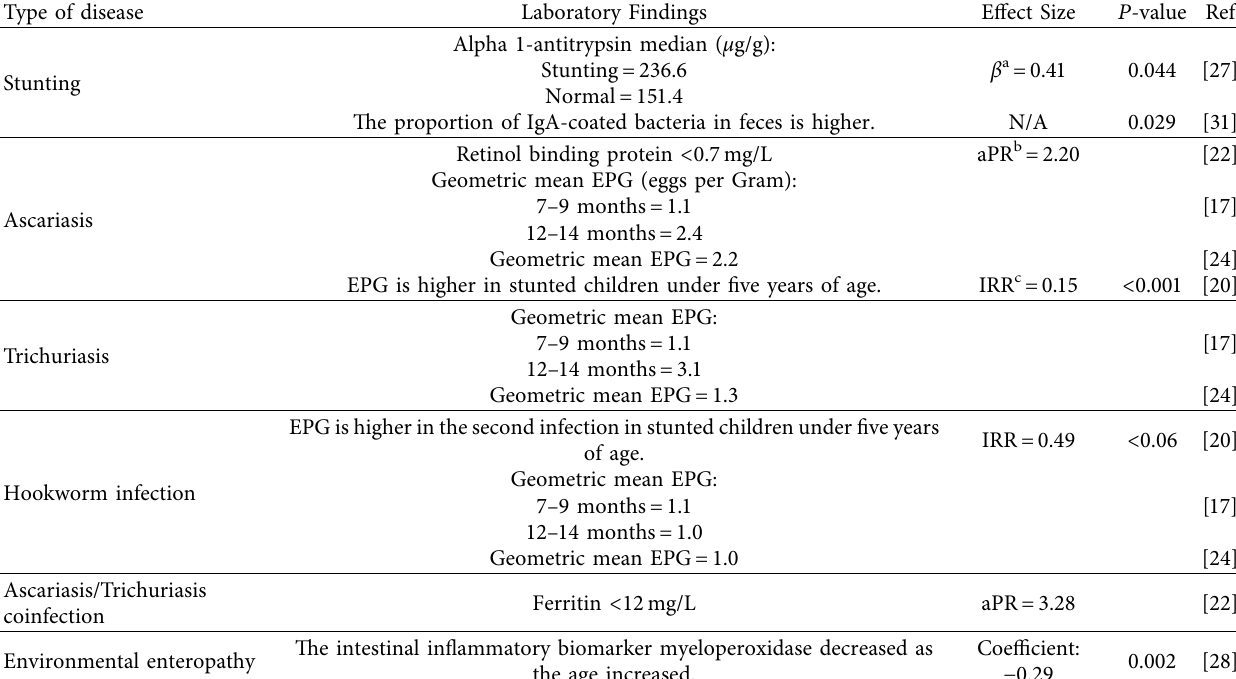
Table 4: Summary of laboratory findings in various studies.